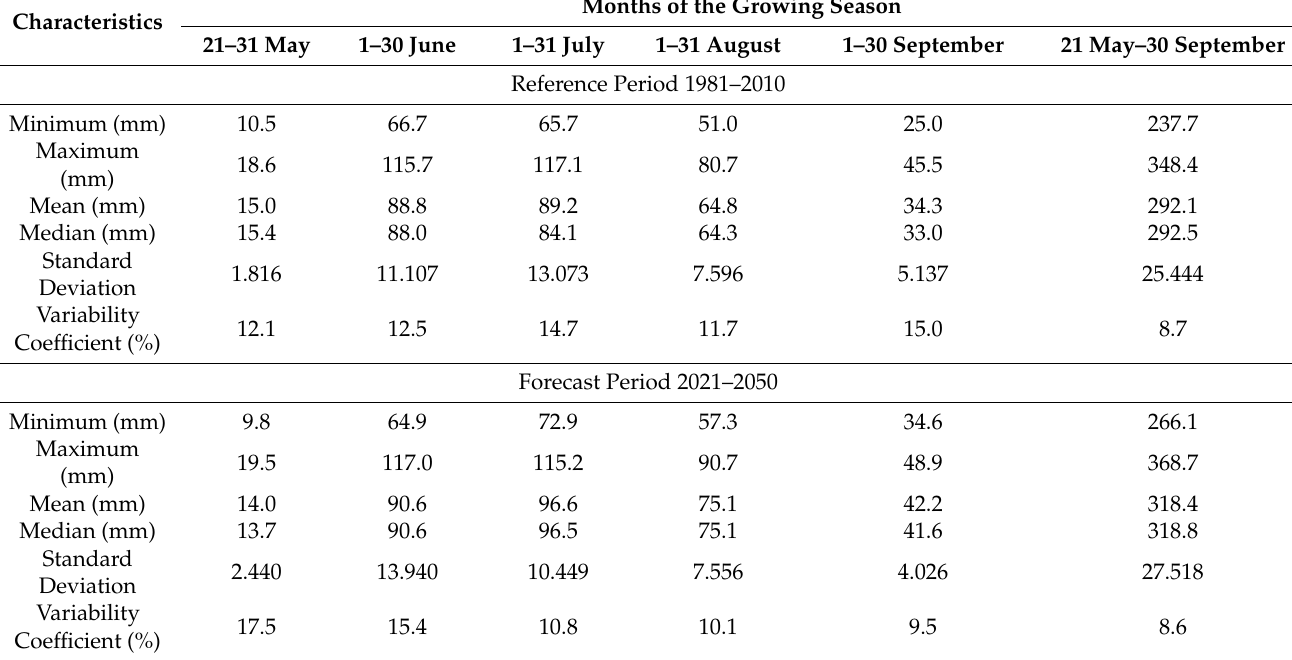
Table 2. Statistical characteristics of the Jerusalem artichoke water needs defined as potential evapo- transpiration in the growing season for the reference and forecast